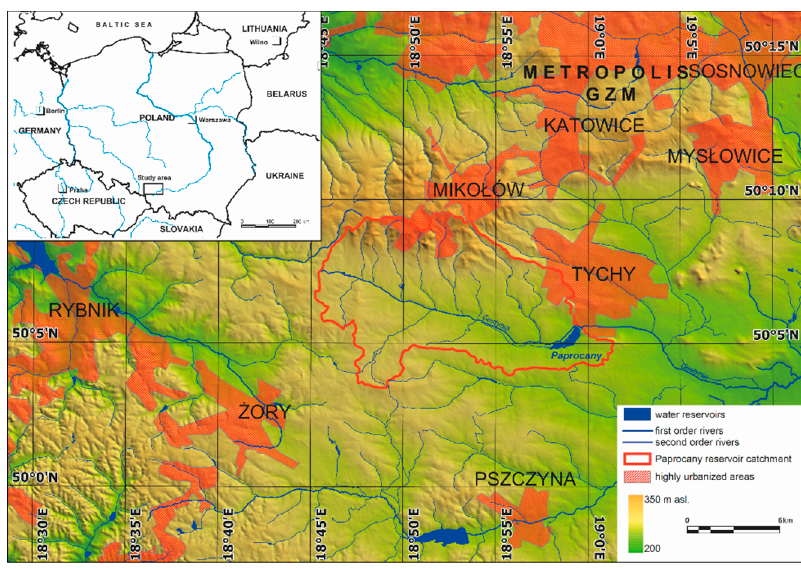
Figure 1. Study area location.